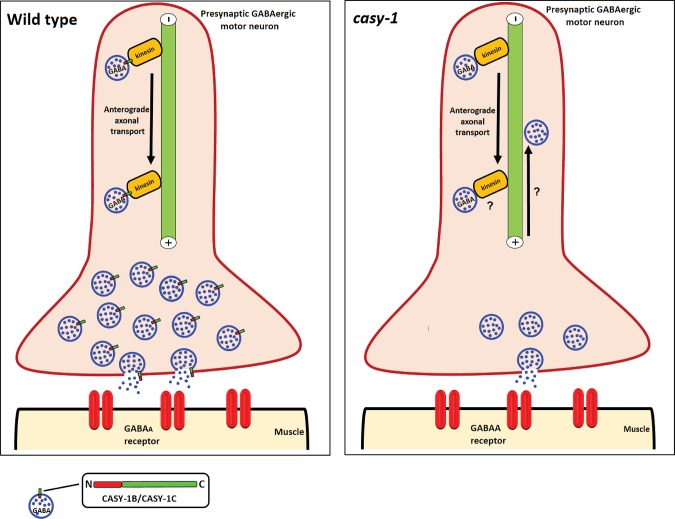
Proposed model for CASY-1 functioning at the NMJ.CASY-1B and CASY-1C, the shorter isoforms are present on the SV precursors. The conserved C-terminal of CASY-1 act as an adaptor to mediate interaction of GABA-specific SVs with the tail region of UNC-104/KIF1A motor protein that mediates fast anterograde axonal transport of synaptic cargo. Mobility dynamics of SV precursors in turn regulates the release kinetics of GABA at NMJ. However in the absence of casy-1, this cargo-adaptor-motor bridge is lost resulting in aberrant anterograde flux of the GABA-specific SV cargo along the axonal pathway. This function of CASY-1B/C shows some similarity to how the mammalian CLSTN1 is thought to function. CLSTN1 has been shown to be required for fast anterograde axonal transport and loss of interaction with kinesin motor results in decreased anterograde trafficking and an increase in retrograde transport of vesicular cargo [18].